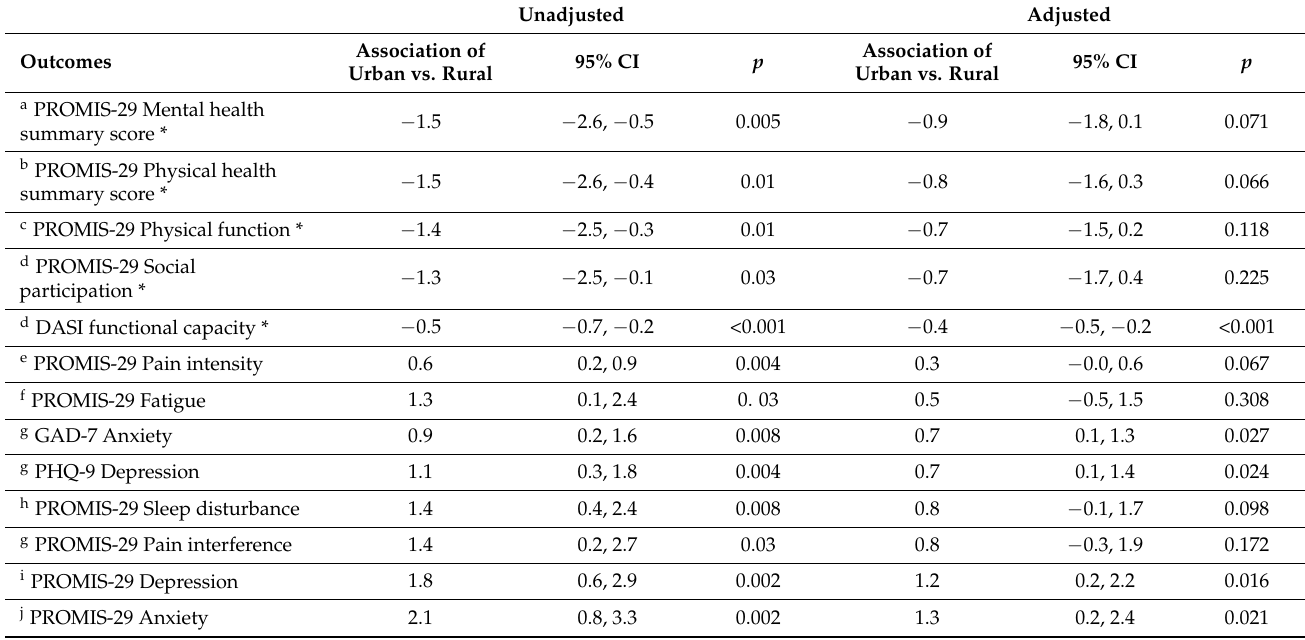
Table 3. Unadjusted and multivariable